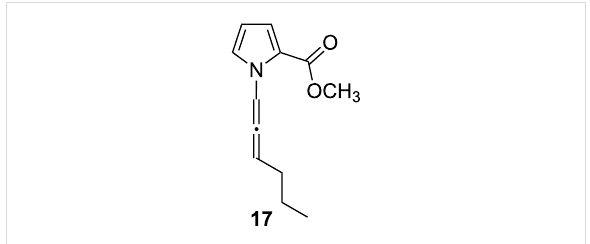
Figure 6: The structure of allene 17 formed during the reaction of 7d with a